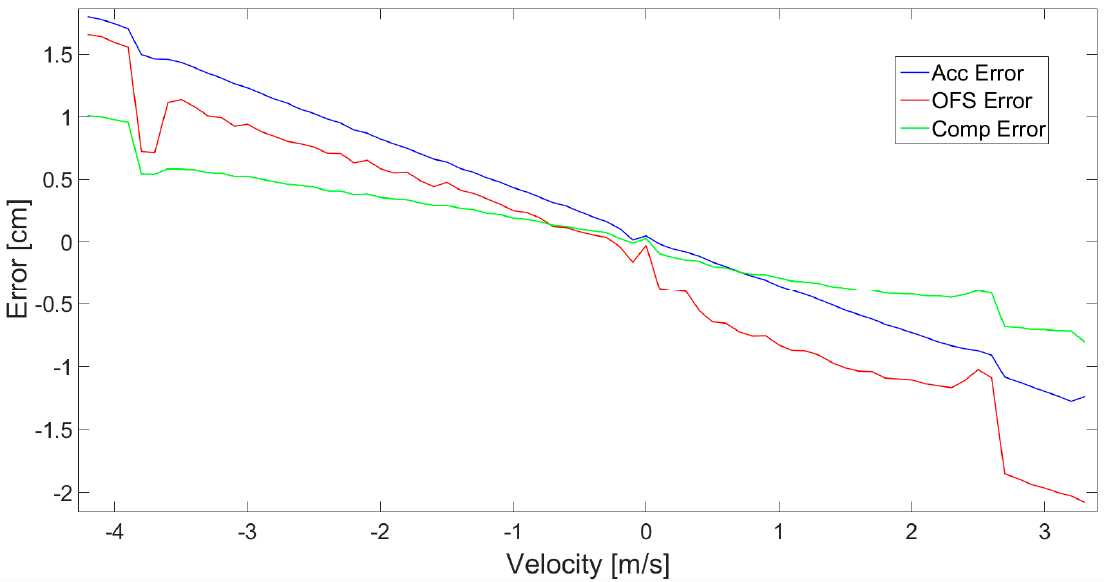
Figure 23. The displacement error in relation to movement velocity for 3 experimental cases.